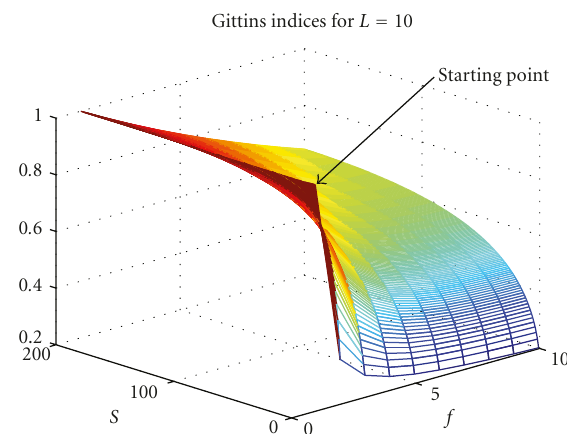
Figure 8: The Gittins Indices for the truncated state space.